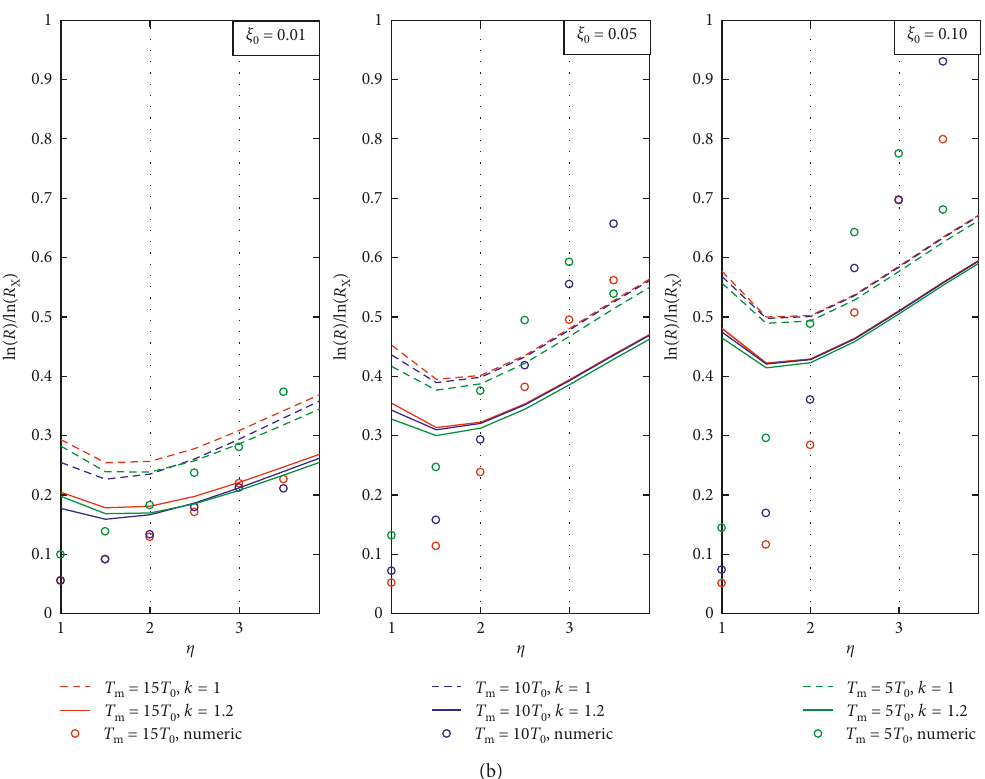
Figure 13: Numerical and analytical results in function of k